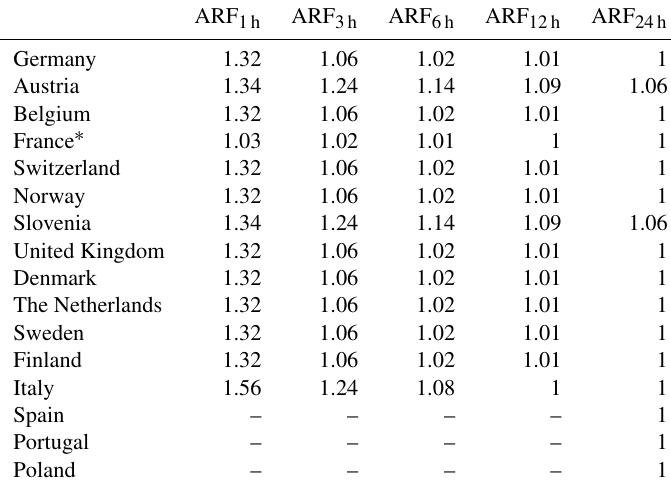
Table 2. Applied areal reduction factors (ARFs) including temporal correction.